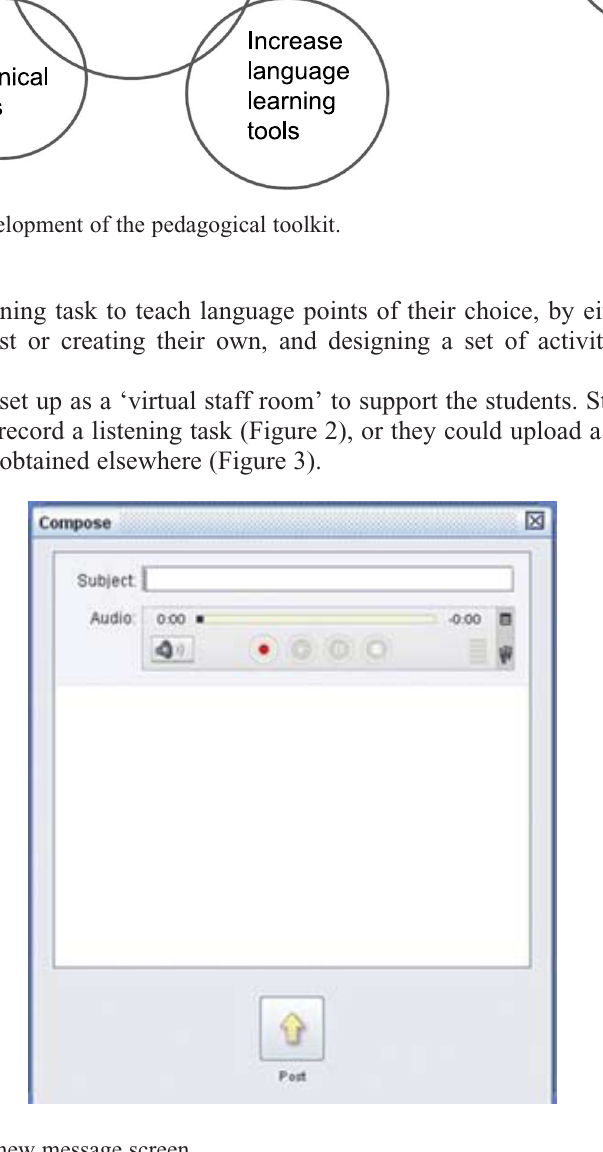
Figure 2. VB new message